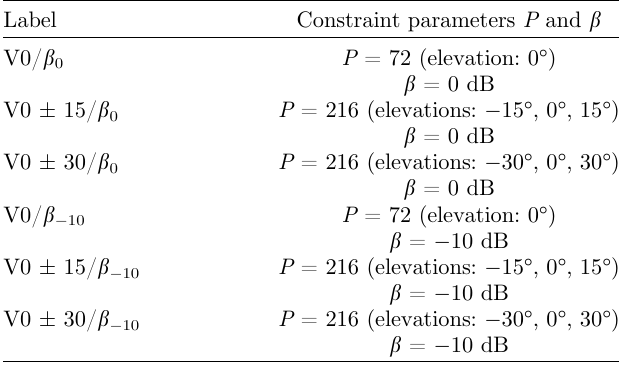
Table 1. Overview of values chosen for the parameters P and b , resulting in 6 sets of spectral weights. Each set of spectral weights was calculated for 185 head